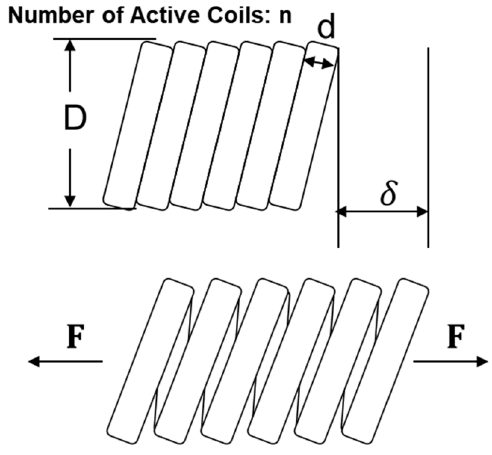
Figure 2. Parameters of coil spring.